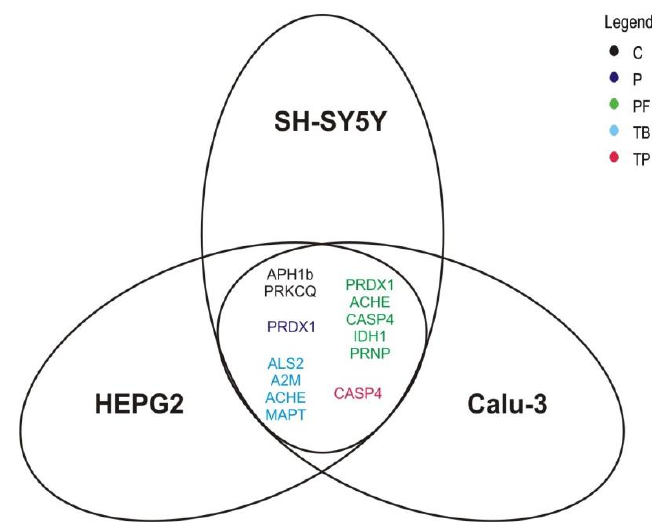
Figure 6. Analysis of methylxanthine-mediated transcriptional effects, independent of cell type. The Venn diagram illustrates the genes of which the expressional changes, mediated by the analyzed methylxanthines (shown in different colors), are conserved over the three cell lines SH-SY5Y, HEPG2 and Calu-3. C: caffeine, TB: theobromine, TP: theophylline, P: pentoxifylline, PF: propentofylline.